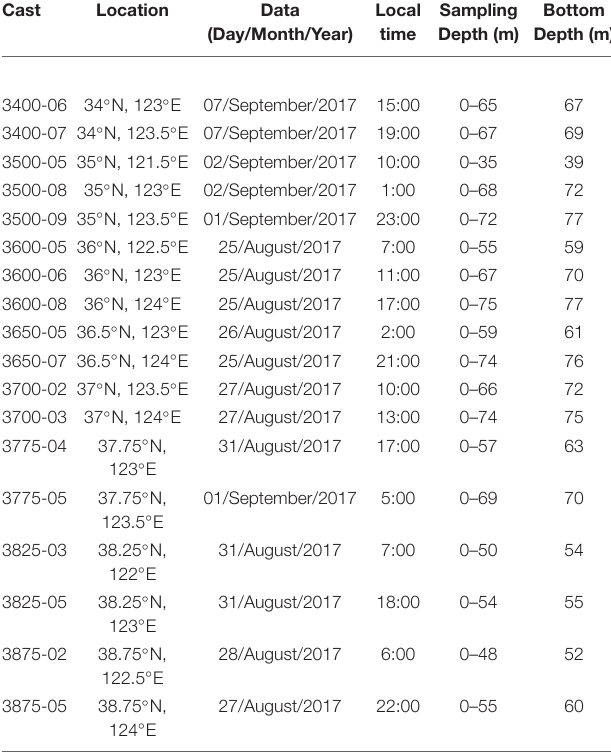
TABLE 1 | Time and depths of VPR stations used during August to September,